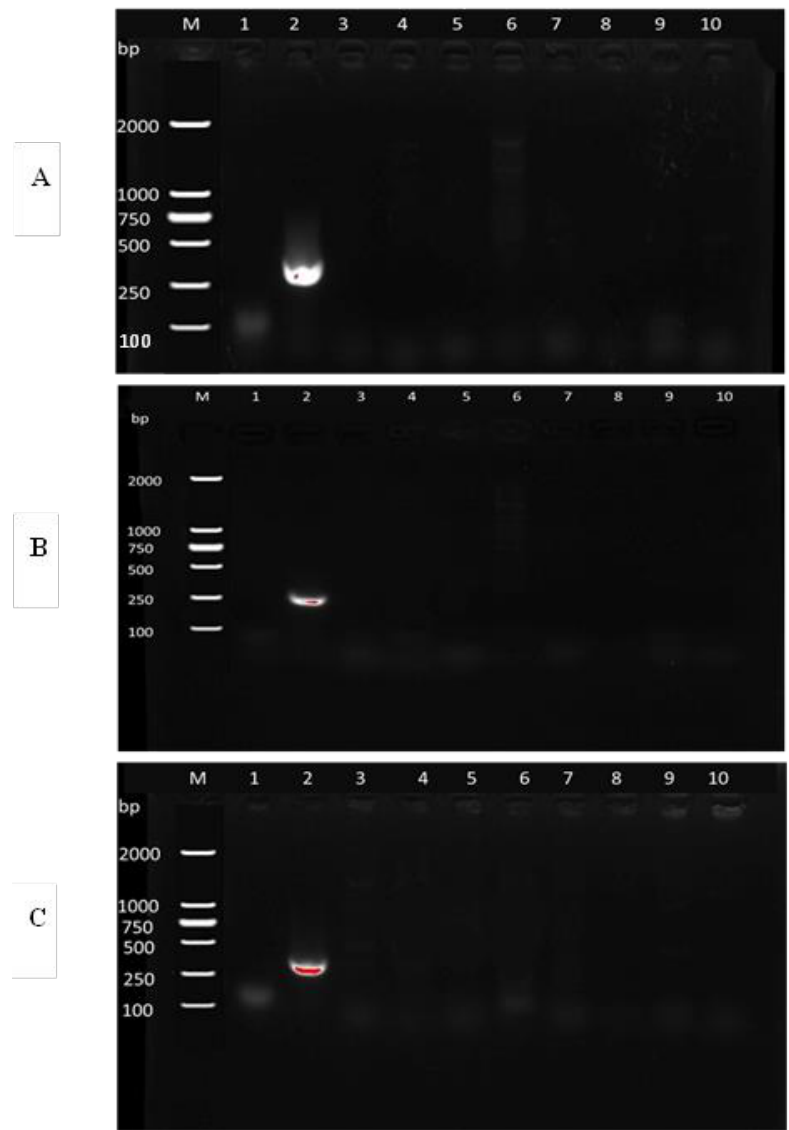
Figure 4 : Diagnosis of larvaebased on species specific primer from guava fruit. A. Chittagong sample, B. Madaripur sample, 3. Bakergonj sample. Line 1 is B. correcta, Line 2 is B. dorsalis, Line 3 is B. latifrons, Line 4 is B. tryoni, Line 5 is B. zonata , Line 6 is Z. bezziana, Line 7 is Z.cilifera, Line 8 is Z.cucurbitae, Line 9 is Z.scutellata, Line 10 is Z.tau and line M:D2000